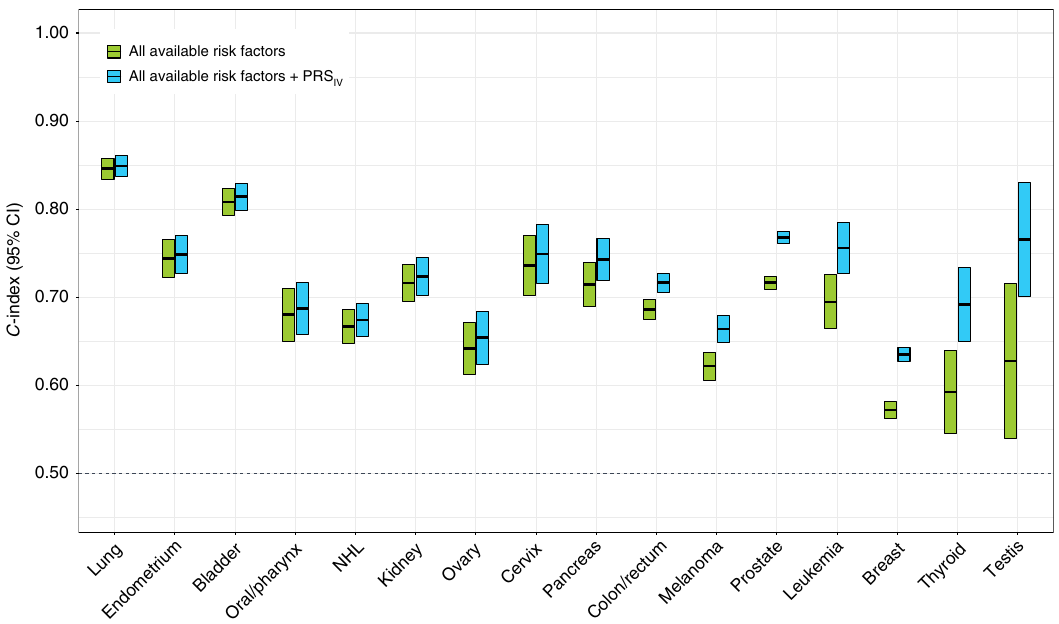
Fig. 2 Assessment of model discrimination based on Harrell ’ s C -index between 1 and 5 years of follow-up time. Comparisons are conducted between the most comprehensive risk factor model for each cancer, including all available lifestyle-related risk factors and family history (if applicable), and a nested model that also includes the standardized polygenic risk score (PRS IV ) for that cancer and the top 15 genetic ancestry principal prediction accuracy for melanoma ( C PRS = 0.664, Δ C = 0.042), was low for some rarer cancers, such as testicular ( n = 52) and breast ( C PRS = 0.635, Δ C = 0.063), and colorectal ( C PRS = 0.716, thyroid ( n = 191), as well as cancers with genetic risk scores based Δ C = 0.030) cancers, which have multiple environmental risk on relatively few variants. Changes in the AUC at 5 years of factors. The highest overall C -index was observed for lung ( C PRS = 0.849) and bladder ( C = 0.814) cancers, which was primar- PRS ily attributed to non-genetic predictors ( C without PRS: lung = 0.846; bladder = 0.808). However, it is worthwhile noting that despite having a large Δ C , the precision of the C -index estimates